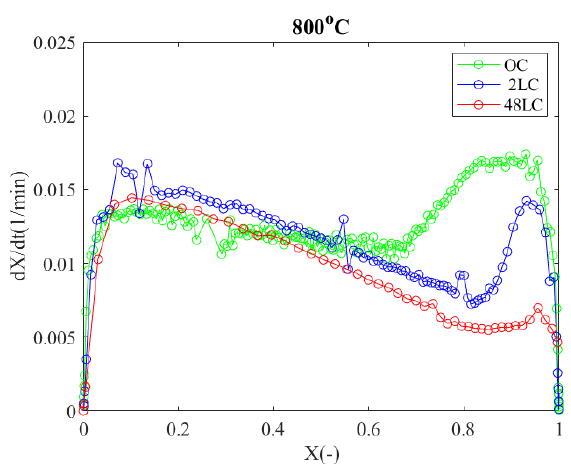
Figure 15. Gasification rate versus conversion for OC, 2LC, and 48LC at different temperatures.